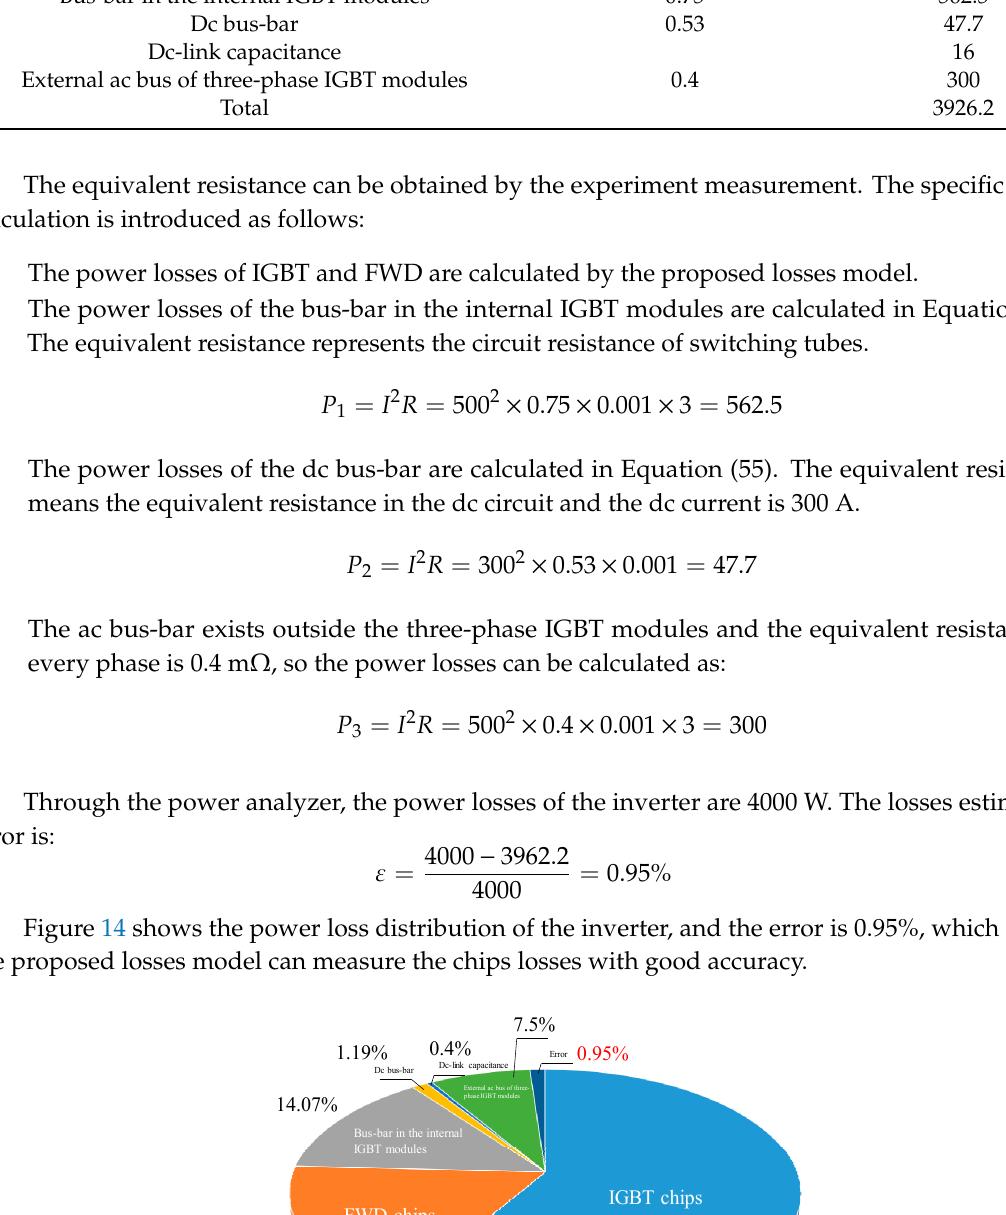
Table 4. Power losses of the inverter .